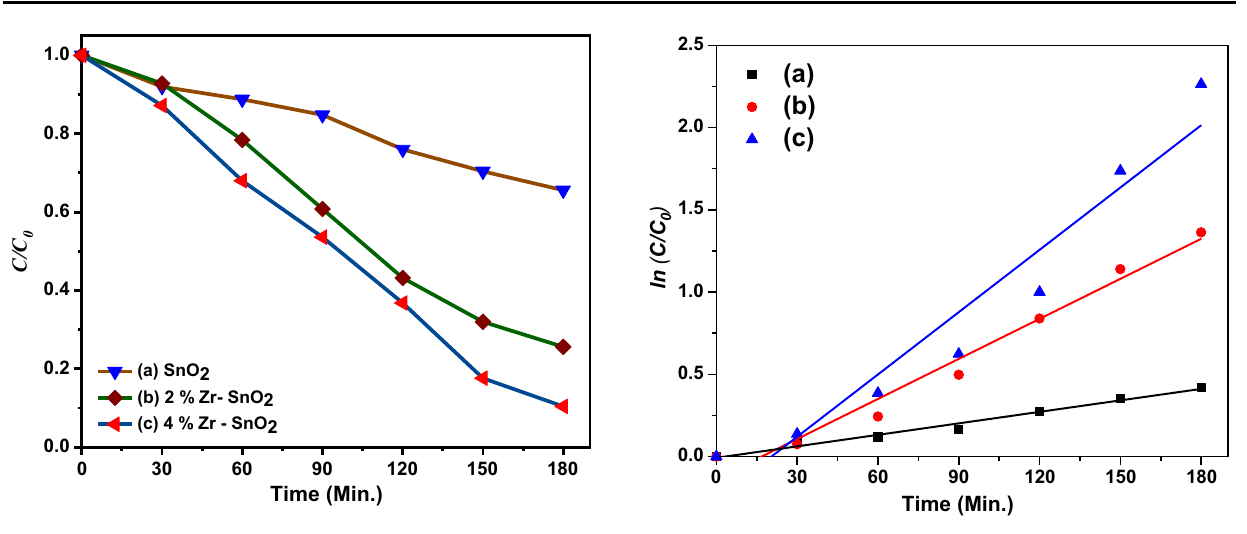
2 , (b) 2% Zr-doped SnO 2